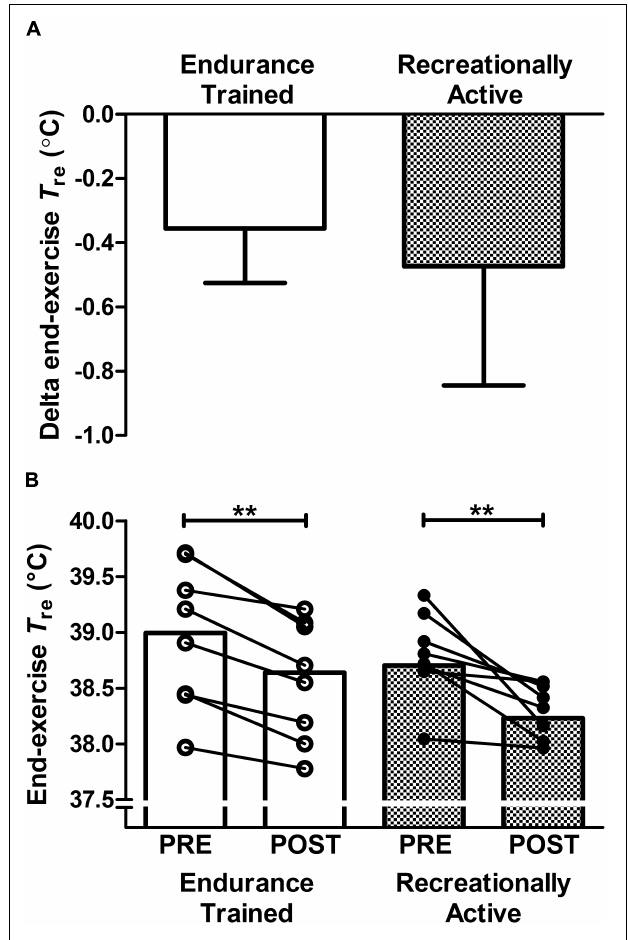
FIGURE 1 | Effect of 6-day post-exercise hot water immersion heat acclimation on end-exercise rectal core temperature ( T re ) following a 40-min submaximal treadmill run at 65% ˙ VO 2max in the heat (33 ◦ C, 40% RH) in endurance trained and recreationally active individuals. Bars represent mean ± SD of the PRE to POST change (A) and mean at PRE and POST (B) for end-exercise T re . Lines between bars represent individual participant responses. ∗∗ P < 0.01 denotes POST lower than PRE (main effect of